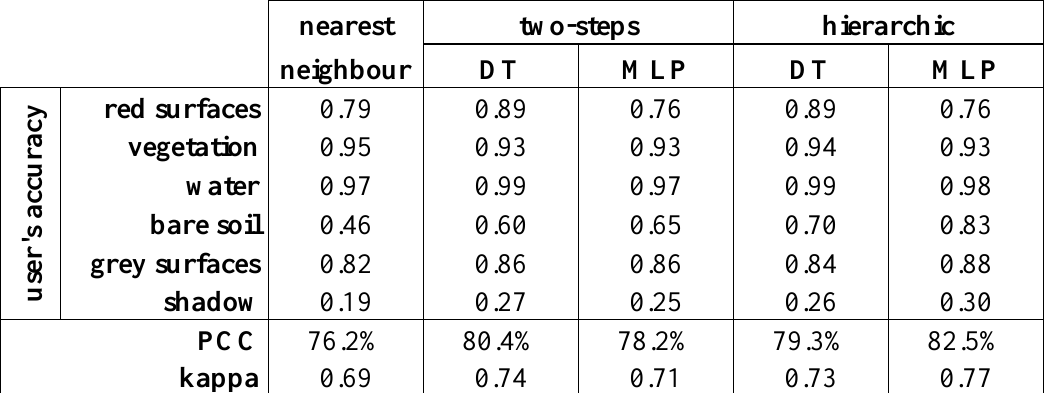
Table 4. Per class user’s accuracies, PCC and kappa values for the five classification